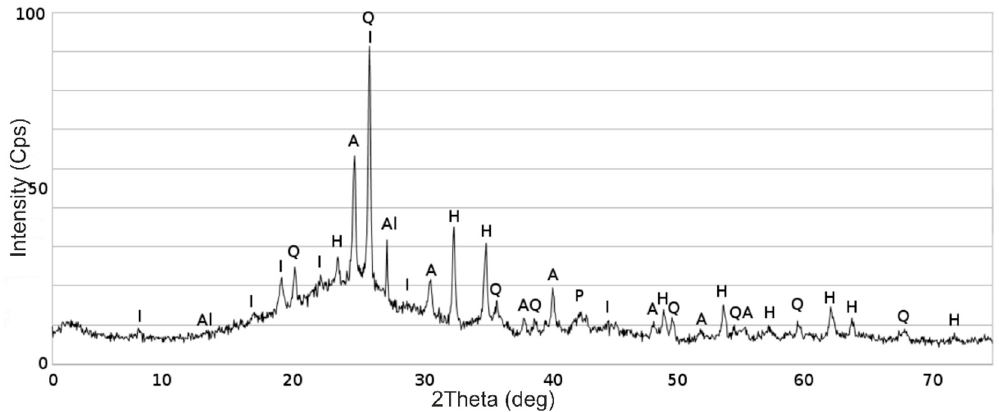
Figure 10. X-ray diffraction pattern of fly ash from the combustion of gasification residue resulting from the gasification of coal from the Janina deposit, Q—quartz, I—illite, H—hematite, A—anhydrite, P—periclase, Al—albite.